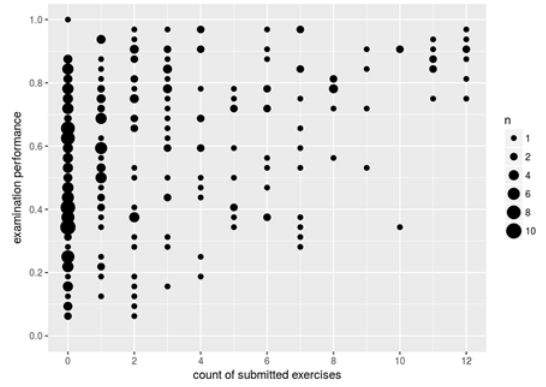
Fig. 5. Relation of examination performance to number of submitted homeworks (aggregated by week) in the preceding